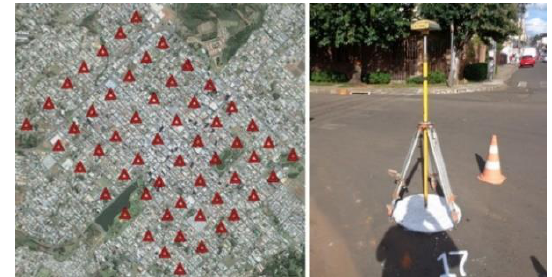
Figure 4: (a) Layout of control points. (b) Circular design signalized at the ground. (Ercolin Filho et al.,